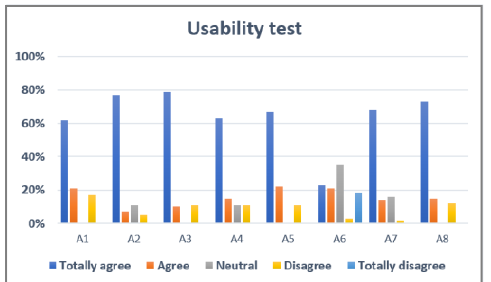
Figure 18. Comparison of the results of the usability test. In general, the use of simulations helps the learning process, but the professor should make sure that the students understand how to use the platform.